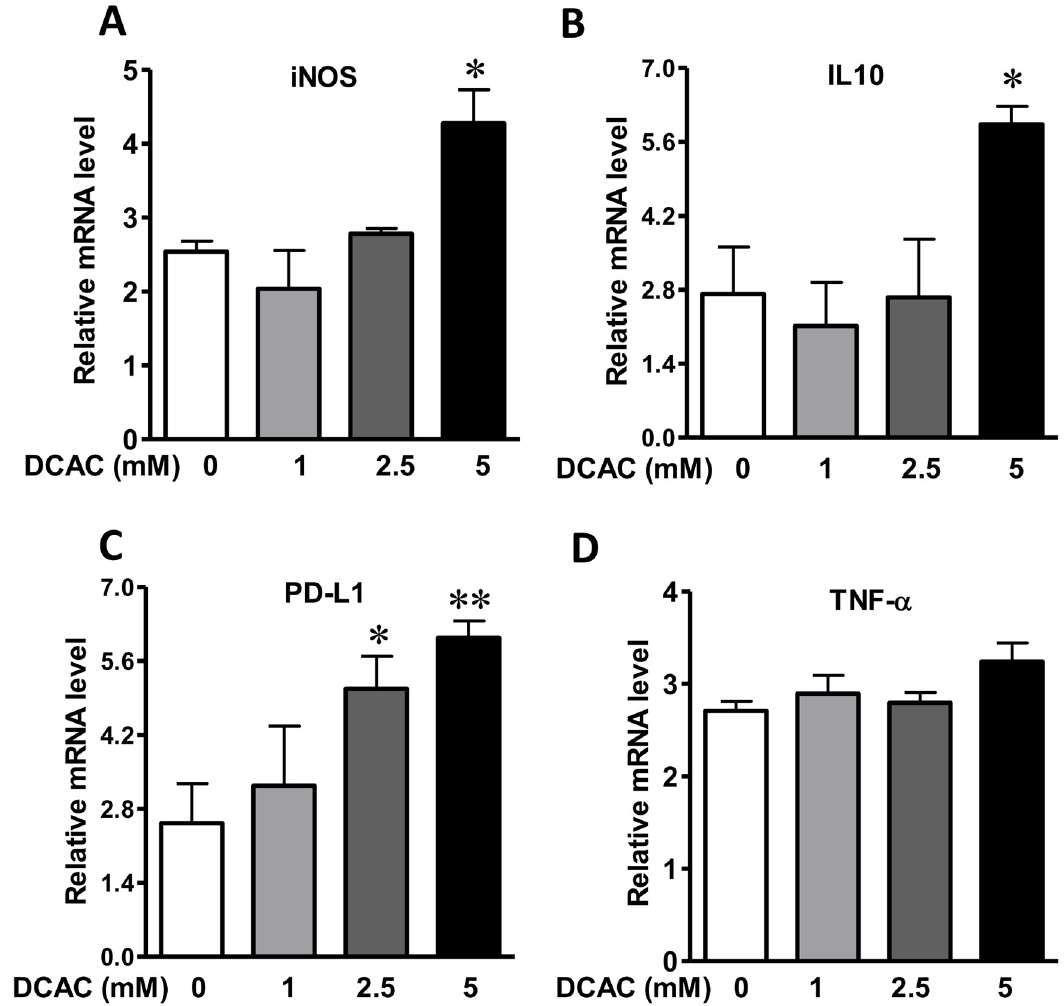
Fig 3. Effect of DCAC on the expression of iNOS, inflammatory cytokines and apoptosis related gene in KCs. KCs are pre- treated with DCAC for 24 h and cultured with or without LPS (200 ng/ml) for 4 h. qPCR was performed to determine the expression of iNOS and inflammatory cytokines: iNOS (A), IL-10 (B), TNF- α (C) and PD-L1 (D). n = 3 in each group. � p < 0.05 vs. the